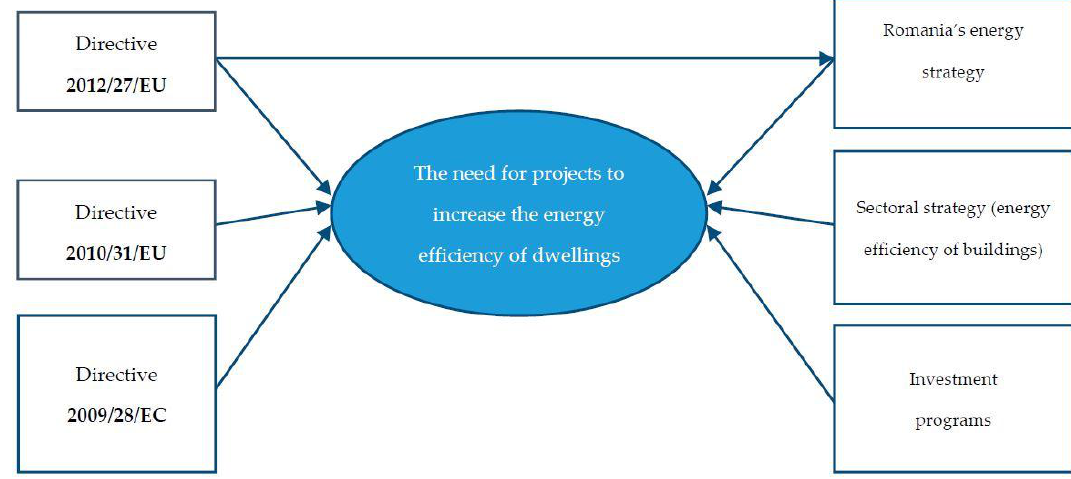
Figure 1. The main determinants of energy efficiency projects for dwellings stock.